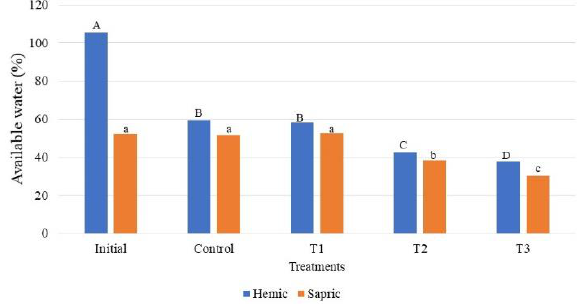
Figure 4. Comparison of available water content (%) between the start and end (week 17) of the growing period for all treatments in hemic and sapric peat materials. Capital letters refer to mean separations among treatments for hemic material, while lowercase letters refer to mean separations among treatments for sapric material, using Tukey at